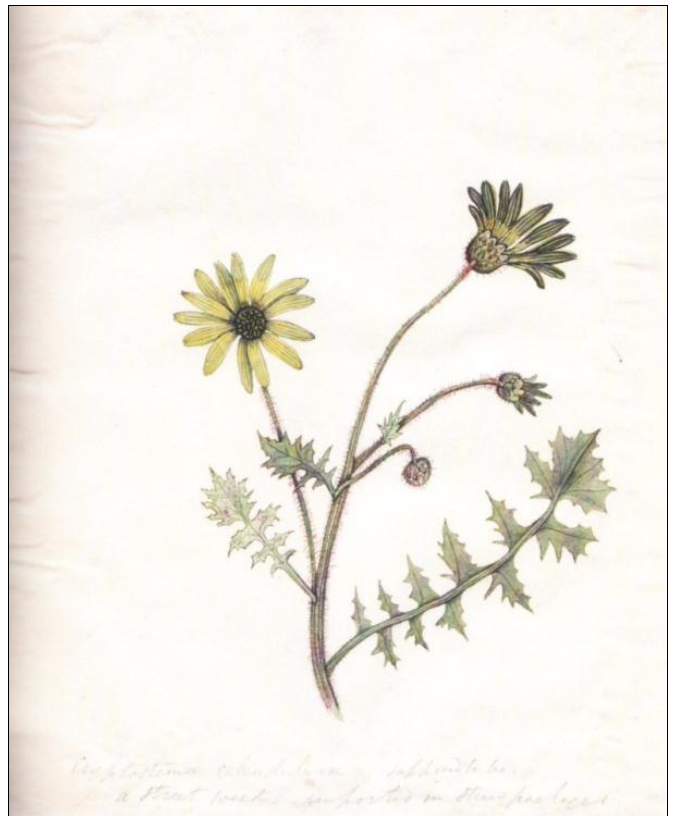
Figure 3 . Plate XVIII of Georgiana Leake’s WildflowerAlbum picturing Cape